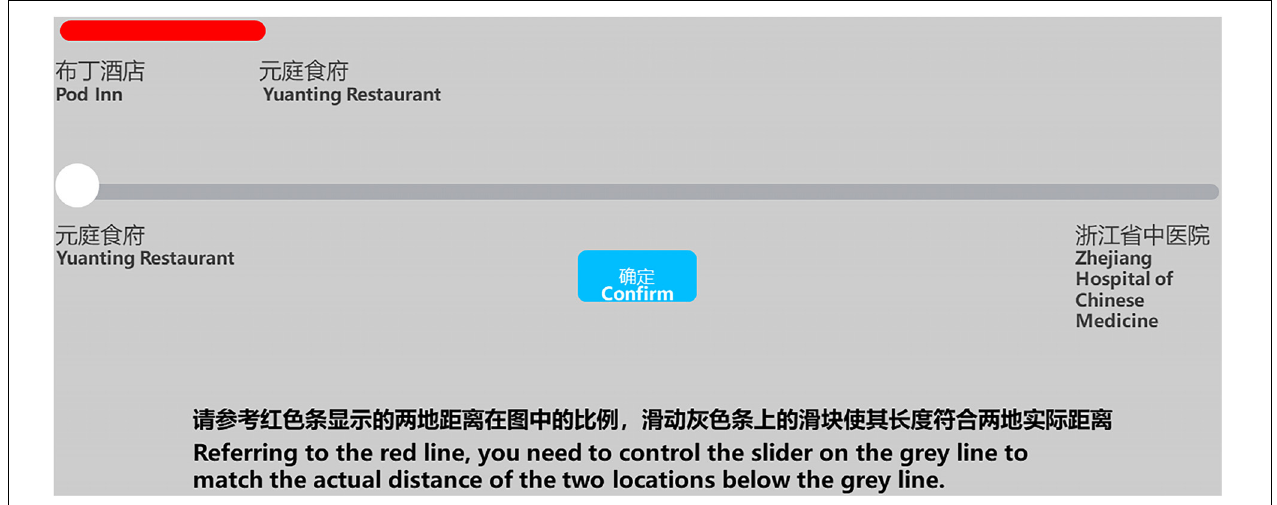
FIGURE 9 | Distance perception representation task: Task display.